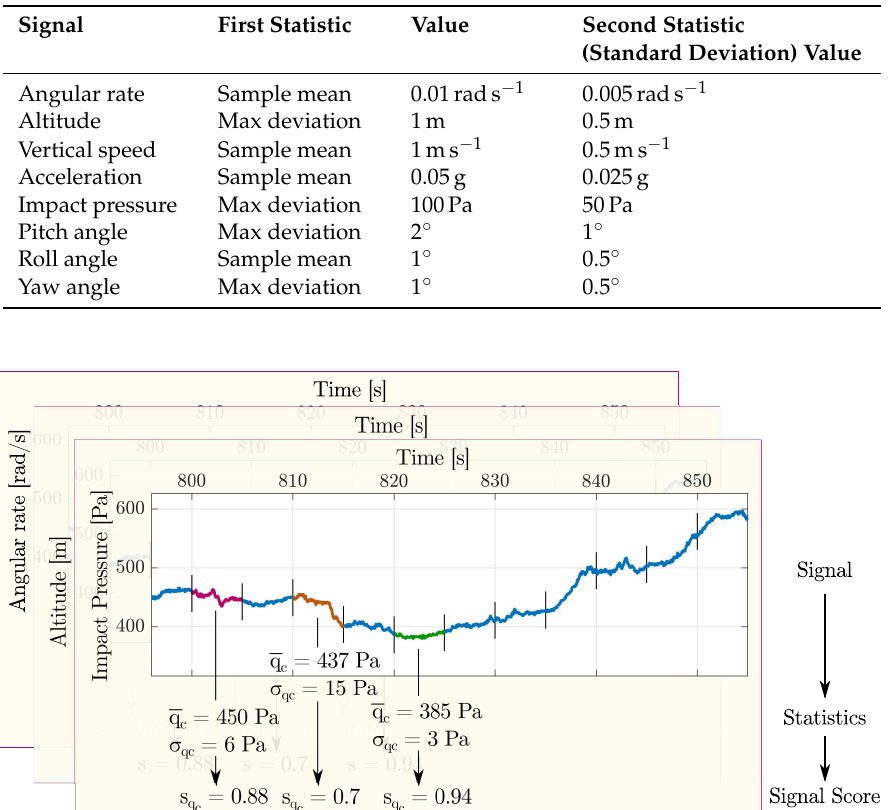
Table 1. List of signals and corresponding statistics.